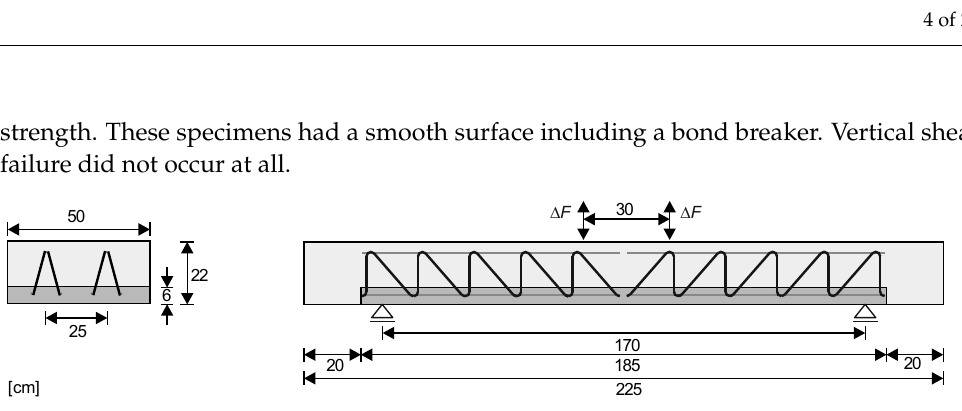
Figure 3. Test specimen and test setup for fatigue tests with lattice girders KTS according to [50].